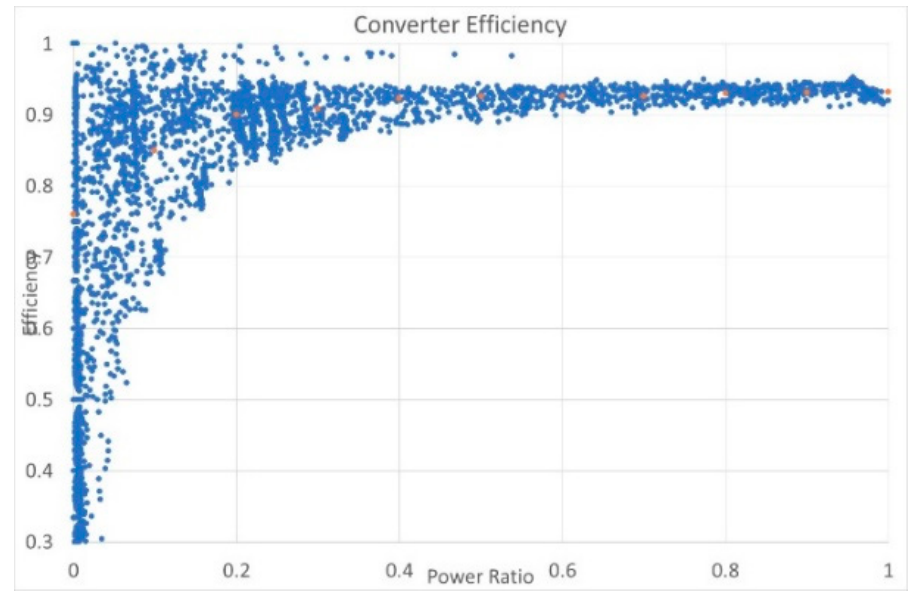
Figure 6. Efficiency of the DC/DC converter.